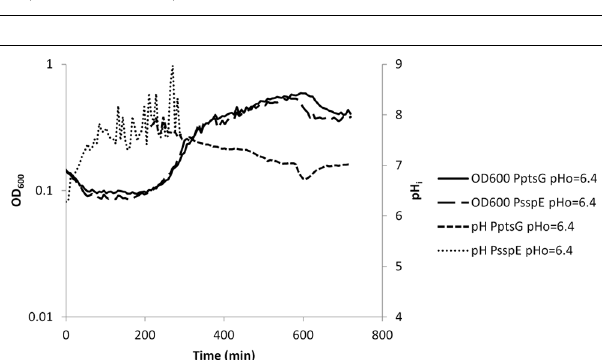
FIGURE 4 | Internal pH as measured with IpHluorin expressed from different promoters. The pH is calculated from when the 390 nm channel exceeded 1,000 units. pH from the spore-specific promoters is calculated from approximately 17 h onward. Lines represent actual data from a representative example.